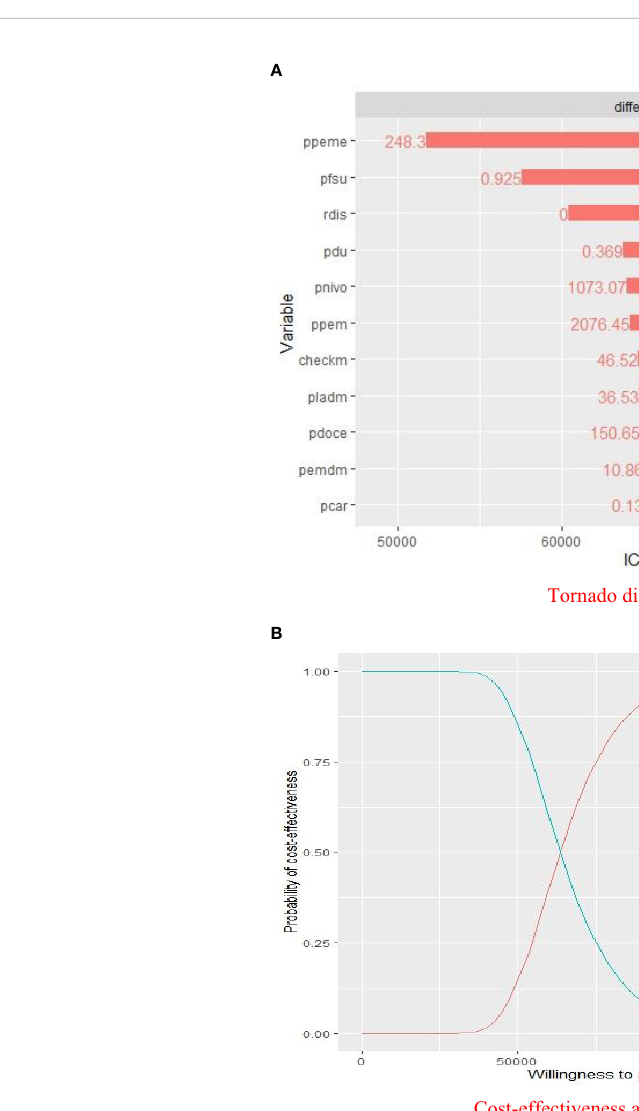
FIGURE 3 | Sensitivity analyses of pembrolizumab group versus placebo group. (A) Deterministic sensitivity analysis of two groups. (B) Probabilistic sensitivity analysis of two groups. ICER, $/QALY; ppeme, price of pemetrexed; pfsu, utility of PFS; rdis, discount rate; pdu, utility of PD; pnivo, price of nivolumab; ppem, price of pembrolizumab; checkm, cost of imaging examination and laboratory test per cycle; pladm, cost of medical service of chemotherapy per cycle; pdoce, price of docetaxel; pemdm, cost of medical service of pembrolizumab therapy per cycle; pcar, price of carboplatin; Willingness to pay, $/QALY; strategy I, pembrolizumab plus pemetrexed and platinum; strategy II, chemotherapy